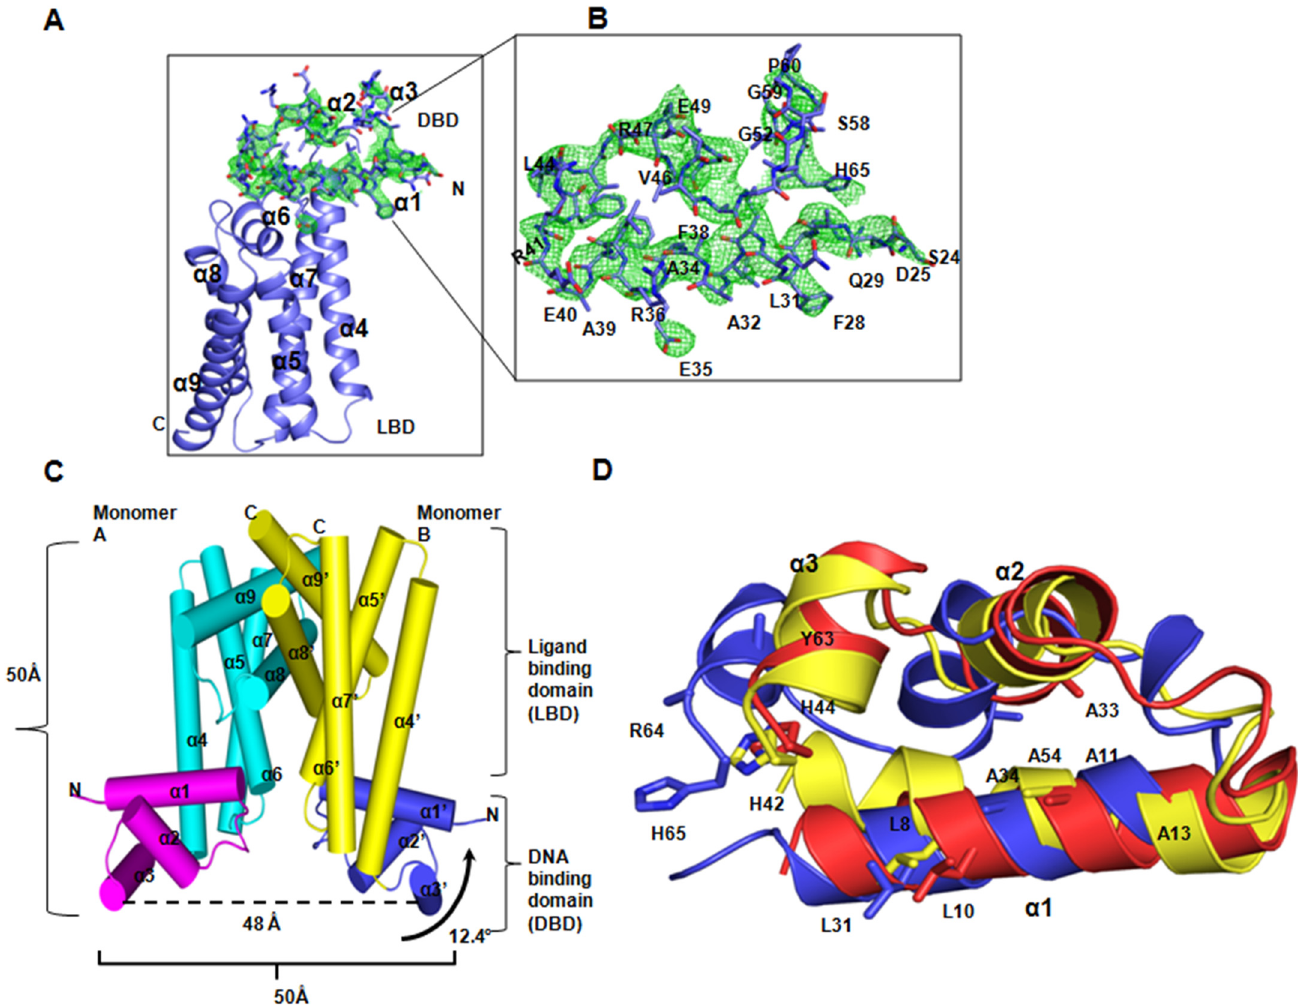
Fig 1. Structural description of Fad35R. A) A monomer of Fad35R, shown in blue color; the ligand binding domain shown in cartoon and the DNA binding domain shown as sticks, superimposed with Fo-Fc map (green). B) Close-up view of Fo-Fc map (green) and corresponding residues of DBD. The Fo-Fc is contoured at 2.5 σ . C) Overview of Fad35R homodimer. Dimer is shown as cylindrical representation and respective helices of two monomers (cyan and yellow) are labeled as α and α '. The dimension of the dimer is indicated and distance between two recognition helices, α 3 and α 3' is shown at the bottom. The twisting of one the DBD around the two-fold NCS axis is also shown. D) Superimposition of DBDs of QacR (yellow), CgmR (red) with that of Fad35R (blue). The conserved and DNA binding residues are shown sticks.